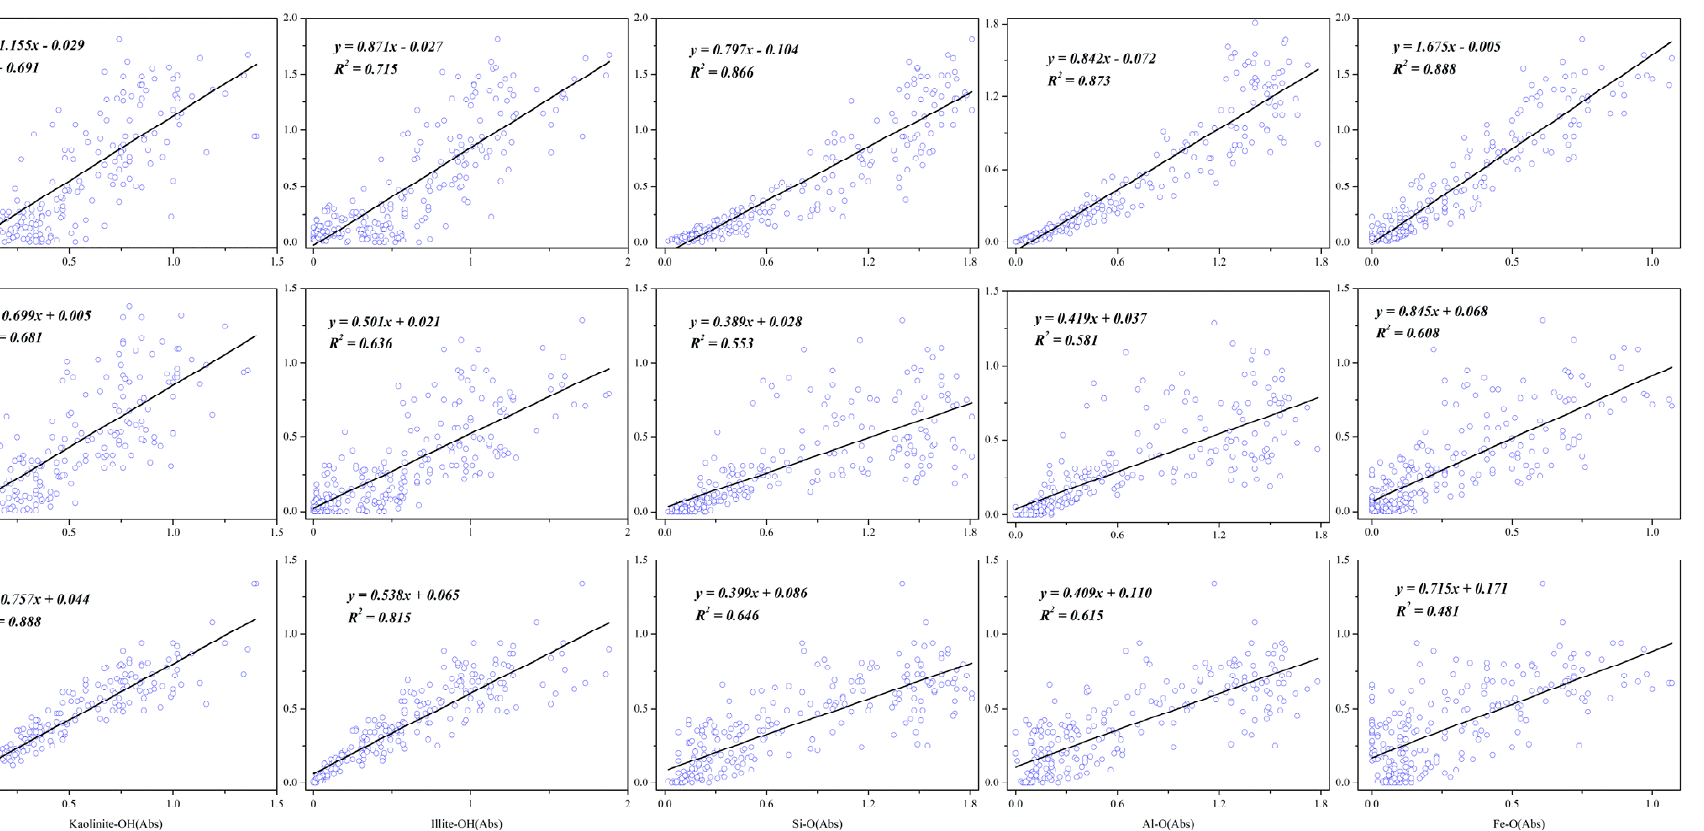
Figure 2. Correlation analysis between organic functional groups and minerals of the OM70 samples. Data were extracted from Figure 1 using Omnic 9.0 (Thermo Fisher Scientific Inc., Waltham, MA, USA).